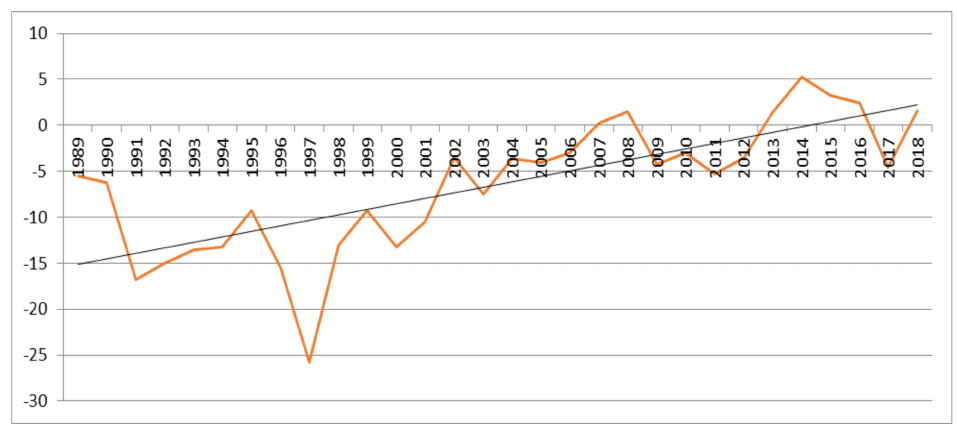
Figure 7. Average height of water table in relation to ground level in March/April in cm in Chippen- ham Fen National Nature Reserve (NNR), a former